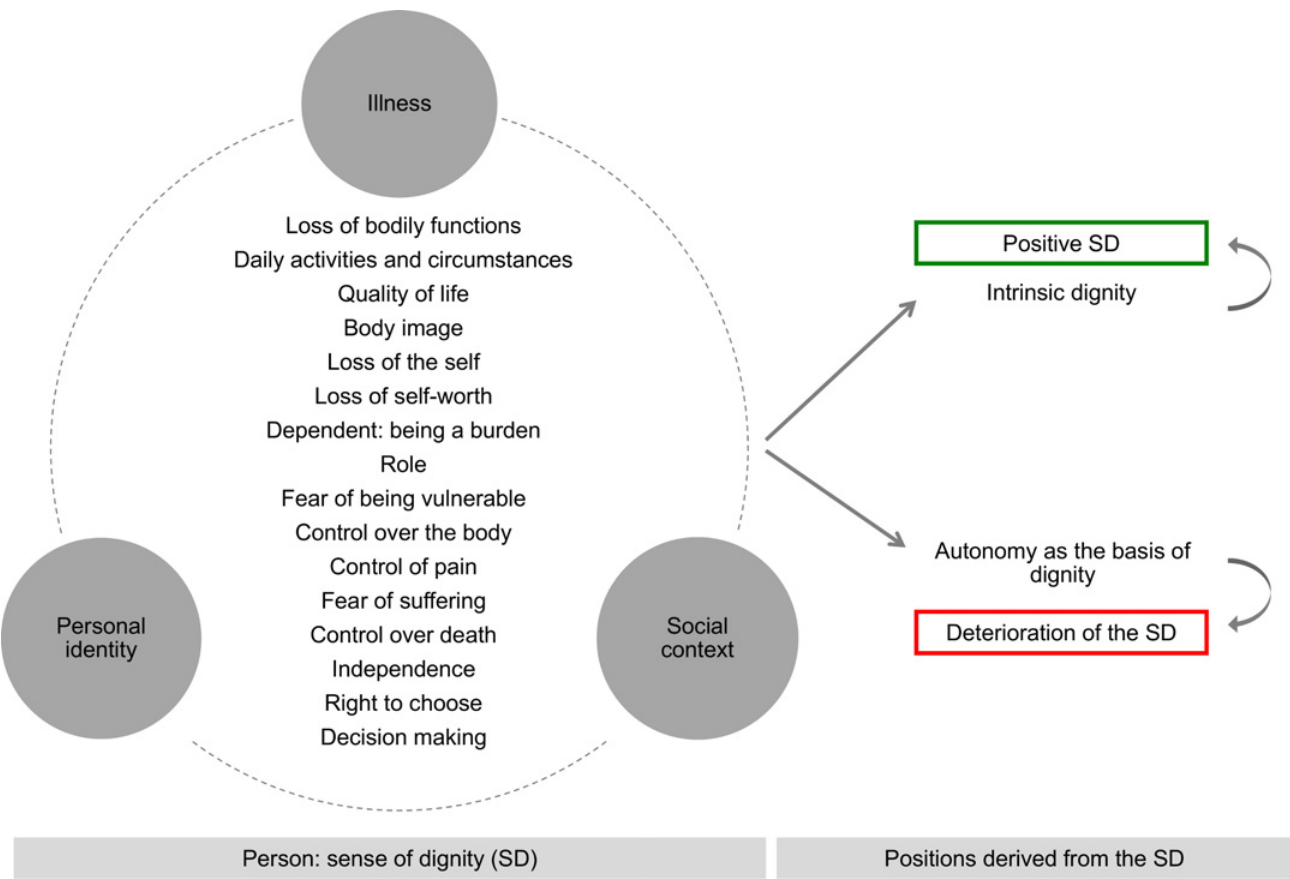
Fig 2. Explanatory model. This figure shows the dynamic integration and synthesis of the themes, subthemes and categories emerging from the lived experience of perceived dignity, autonomy and